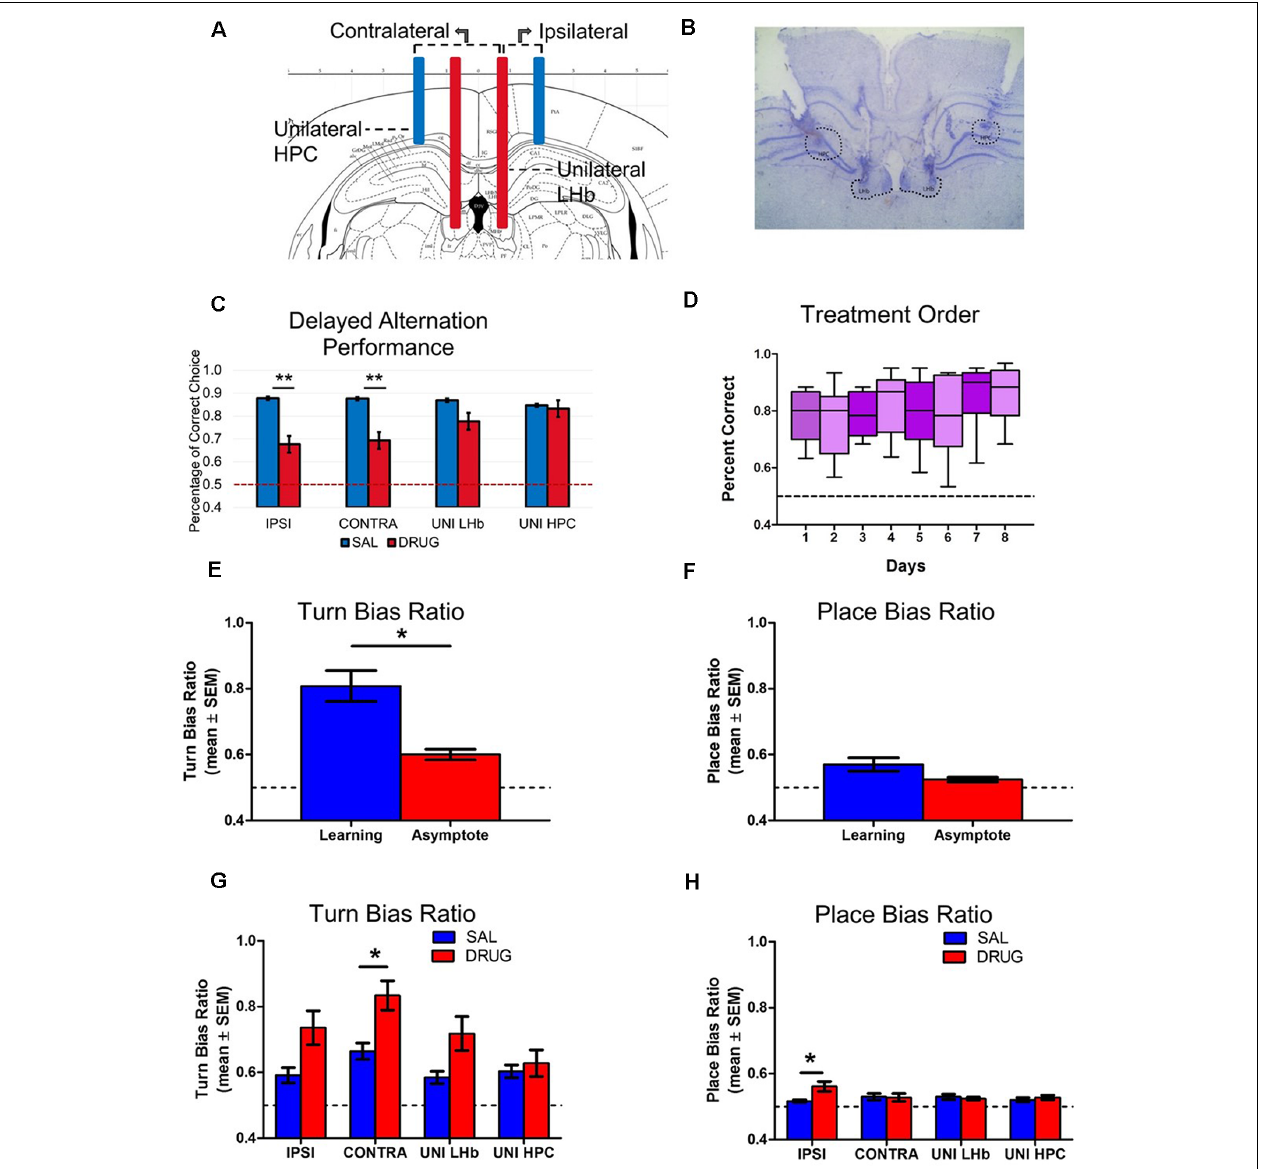
FIGURE 4 | Experiment 2: LHb and HPC disconnection decreases accuracy in a delayed-alternation task. (A) Schematic of ipsilateral, contralateral and unilateral infusion cannula placements within HPC and LHb. (B) Histological example of cannula placements in the HPC and LHb. (C) Any treatment group that impaired both the LHb and HPC showed significant impairments in accuracy ( F ( 3,32 ) = 5.83, p < 0.05). (D) Results revealed no effect of day of injection on overall accuracy on the delayed alternation task ( F ( 7,64 ) = 0.89, ns.). (E) Egocentric turn bias significantly decreased from the Learning phase (0.81 ± 0.04) to Asymptote phase (0.60 ± 0.02; t ( 8 ) = 5.12, p < 0.01). (F) The place bias remained at a relatively low level in both Learning and Asymptote phases (Learning = 0.57 ± 0.02, Asymptote = 0.52 ± 0.01) and did not significantly differ from each other ( t ( 8 ) = 1.78, ns.). (G) A two-way ANOVA of turn bias scores during asymptotic performance revealed main effects of both drug treatment ( F ( 1,32 ) = 17.91, p < 0.01), and injection condition ( F ( 3,32 ) = 13.72, p < 0.01), with no interaction effect ( F ( 3,32 ) = 4.39, ns.). Bonferroni post hoc tests indicated that there was a significant difference between saline and drug treatment in the contralateral disconnection group ( t ( 8 ) = 3.03, p < 0.05). (H) A two-way ANOVA of place bias scores did not show main effects for either drug treatment ( F ( 1,32 ) = 2.86, ns.) or treatment area ( F ( 3,32 ) = 1.06, ns.) but did reveal a significant interaction ( F ( 3,32 ) = 3.03, p < 0.05). Bonferroni post hoc tests indicated that the ipsilateral disconnection group significantly increased place bias scores under drug vs. saline treatment, ( t ( 8 ) = 3.38, p < 0.01). ∗ p < 0.05. ∗∗ p < 0.01. ns = not